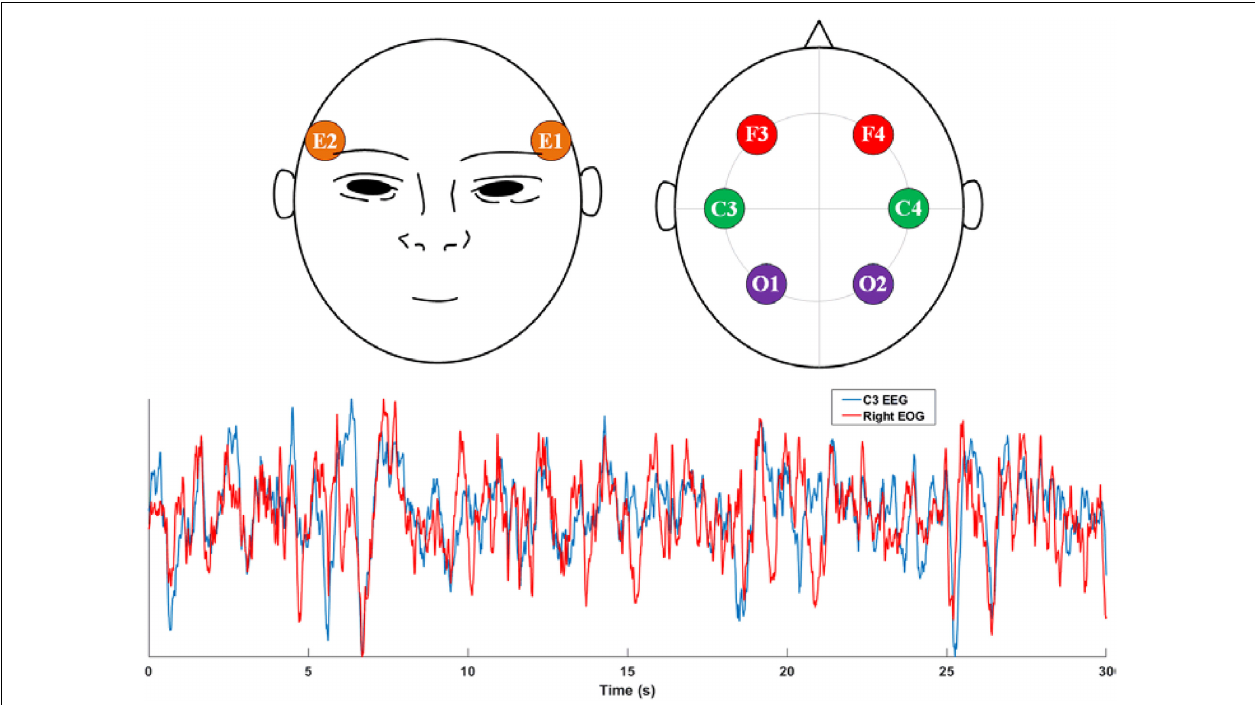
FIGURE 1 | Top: the electrode placement positions of EOG and EEG signals recommended by AASM. E1 and E2 electrodes are used to acquire the left and right EOG, respectively. F3, F4, C3, C4, O1, and O2 are the most-used EEG electrodes in sleep monitoring; Bottom: comparison between C3 EEG signal and the Right EOG (E2)